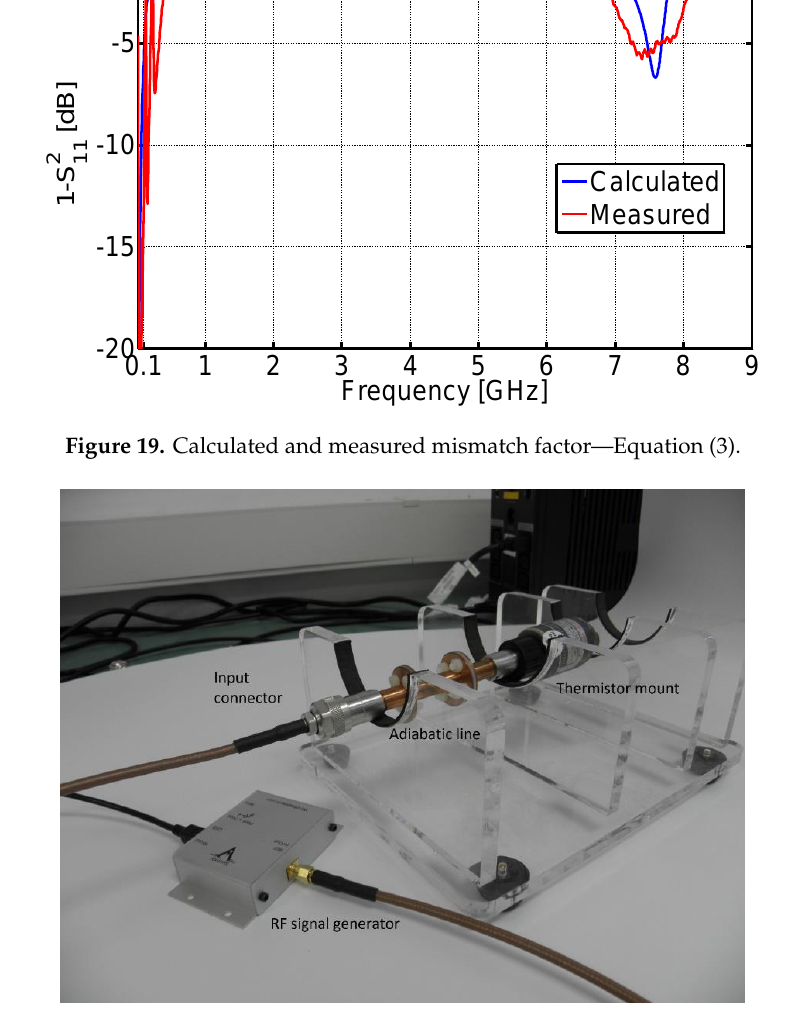
Figure 20. Measurement setup for verifying adiabatic line performance with thermistor .